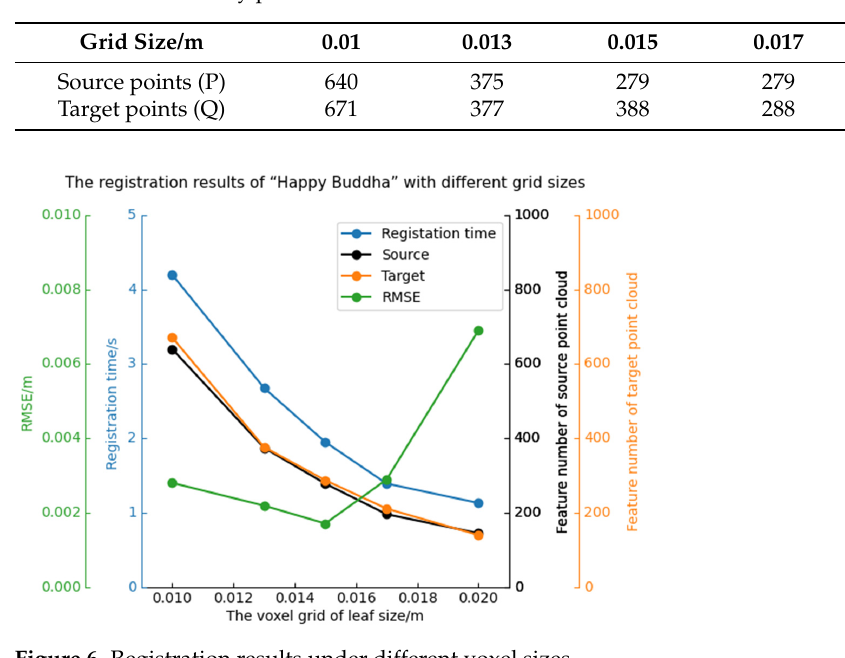
Figure 6. Registration results under different voxel sizes.